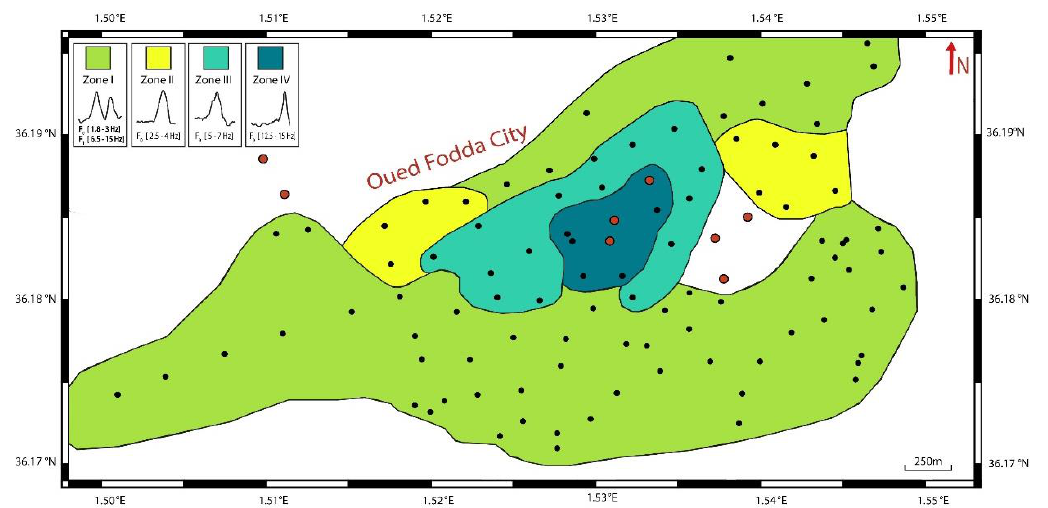
Figure 4. Zonation map of the HVSR curves. Black dots represent the measurement points, and red dots represents the HVSR flat curves.